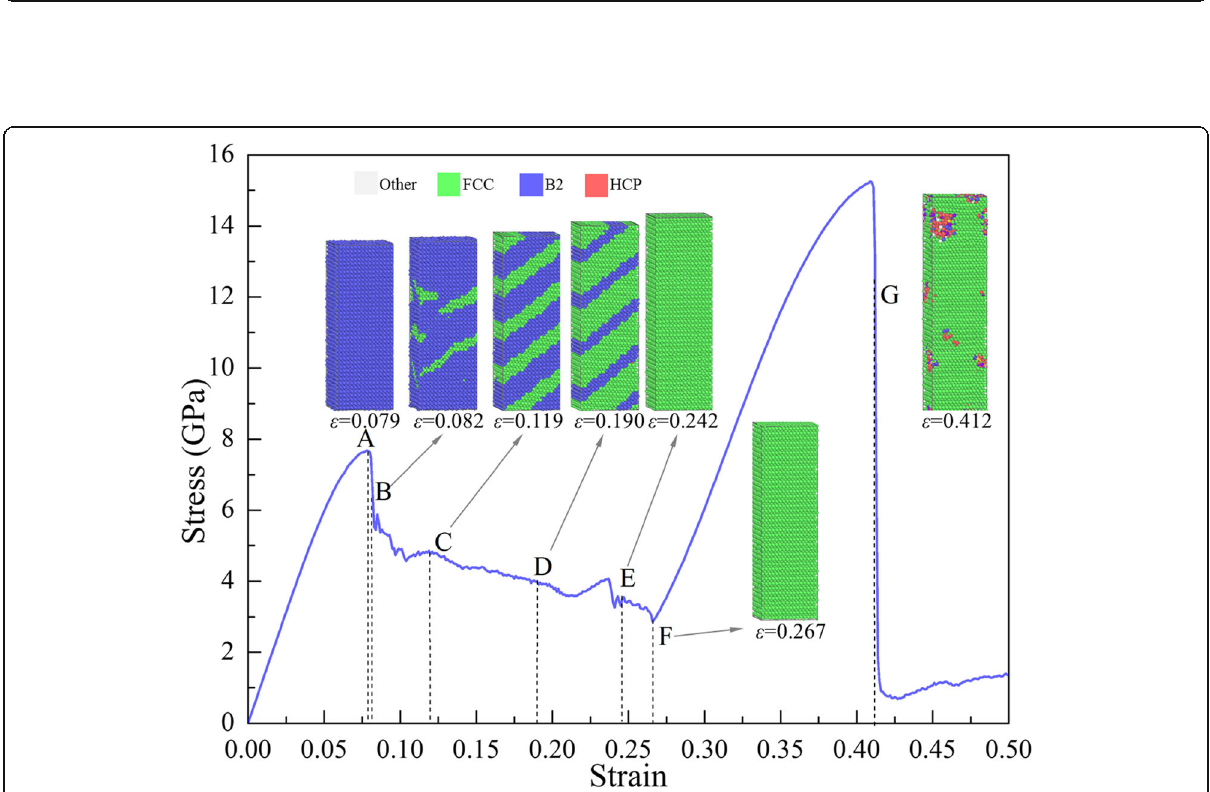
Fig. 5 σ - ε curve of the sample under tension along [001], colored with local structure, with blue, green, and red representing B2, FCC, and amorphous phases,